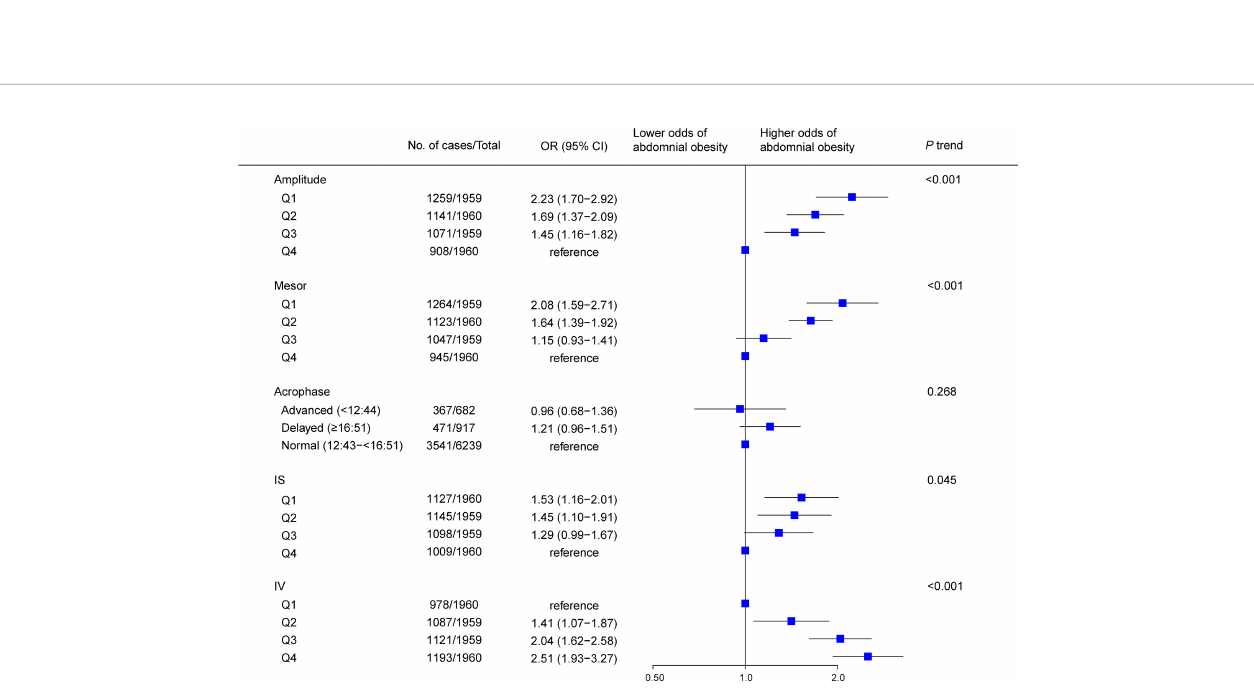
Frontiers in Endocrinology |